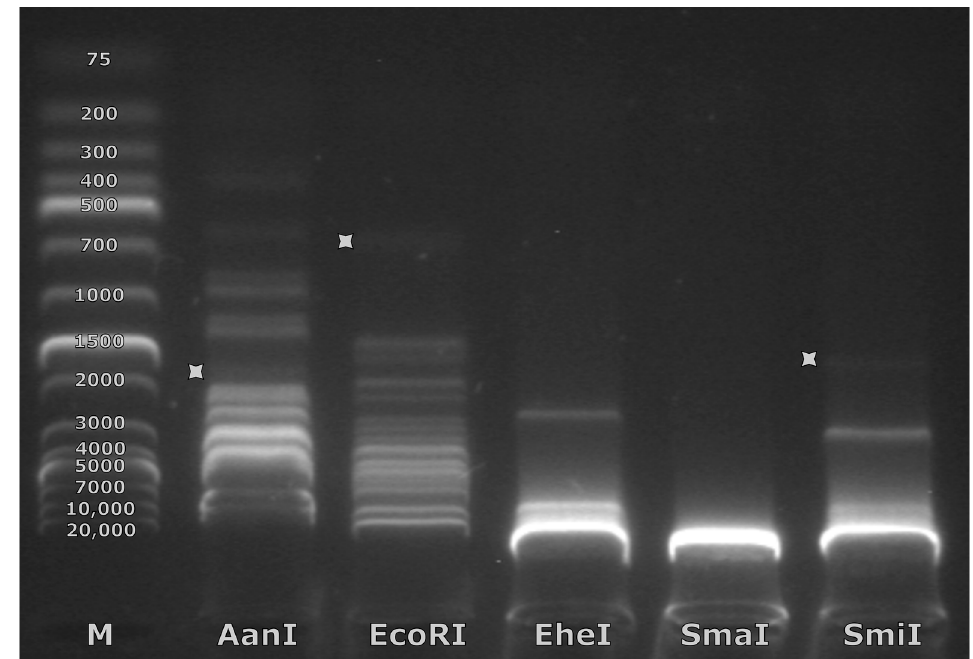
Figure 5. Restriction enzyme generated fragments from Morganella phage Mecenats66 DNA digestion by the selected restrictases. Tracks are named according to the FastDigest restrictase used. Track marked “M” indicates a marker/ladder track, and numeric values on the fragments indicate the ladder fragment sizes in base pairs. In the tracks named AanI, EcoRI, and SmiI, faint bands corresponding to the pac fragments are indicated by grey stars to the right of the respective